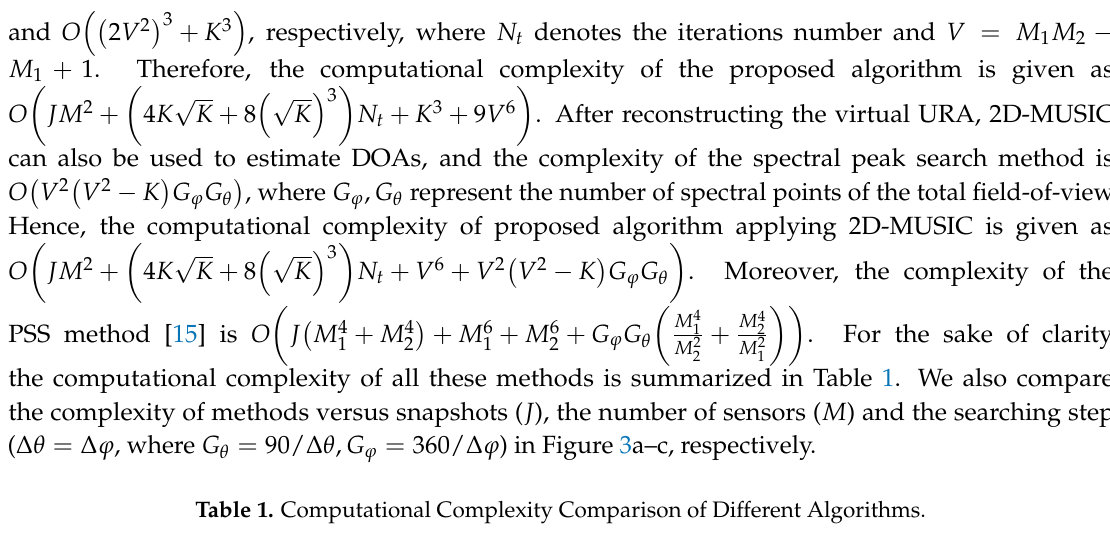
Table 1. Computational Complexity Comparison of Different Algorithms.